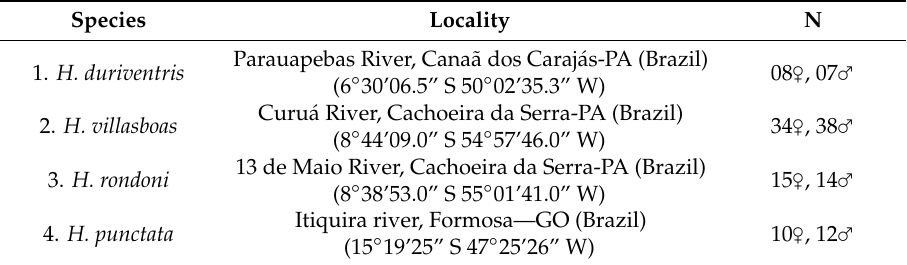
Figure 1. Brazilian collection sites of the three Harttia species cytogenetically investigated in the present study (colored circles) and the ones previously cytogenetically analyzed (white circles: data from [9,13]). 1 . H. duriventris (red circle); 2 . H. villasboas (yellow circle); 3 . H. rondoni (3-green circle); 4 . H. punctata ; 5 . H. gracilis ; 6 . H. carvalhoi ; 7 . H. torrenticola ; 8 . H. longipinna ; 9 . H. loricariformis ; 10 . H. kronei ; 11 . H. absaberi . The boxes highlight the non-sympatric distribution of some species. Table 1. Collection sites and samples size (N) of the species